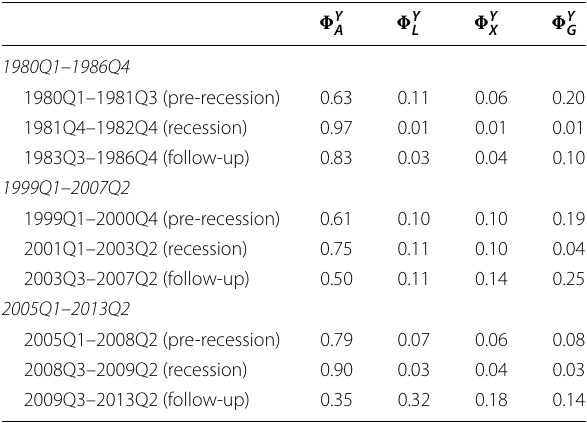
Table 5 (cid:31) -statistics of phases before, during and after Swiss